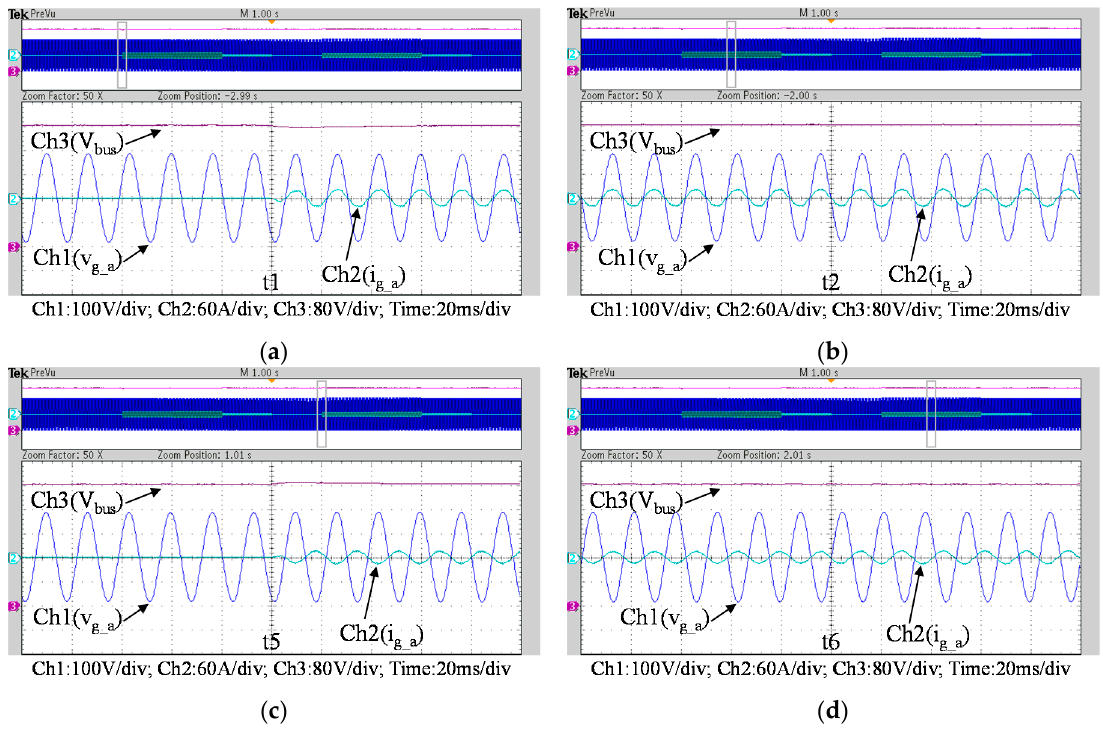
Figure 32. Detailed view of Figure 31b: ( a ) near t1; ( b ) near t2; ( c ) near t5; ( d ) near t6.